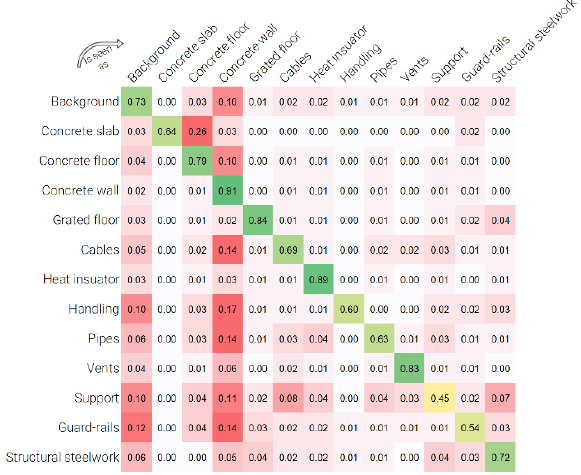
Figure 7. Example of stuff objects predicted by the DeepLabv2. Left : original image. Right : Masks prediction. The large blue object, a ”mirror like” heat insulator, is correctly labeled. A full class colors legend is given in appendix.